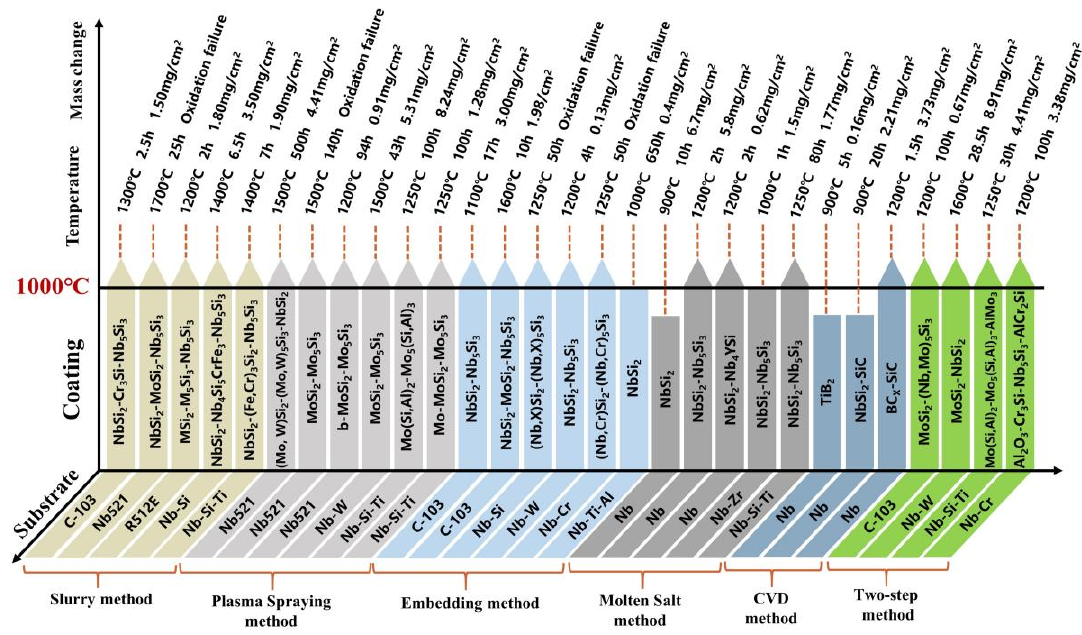
Figure 13. Overview of preparation parameters and oxidation resistance of Nb-based alloys surface coatings.